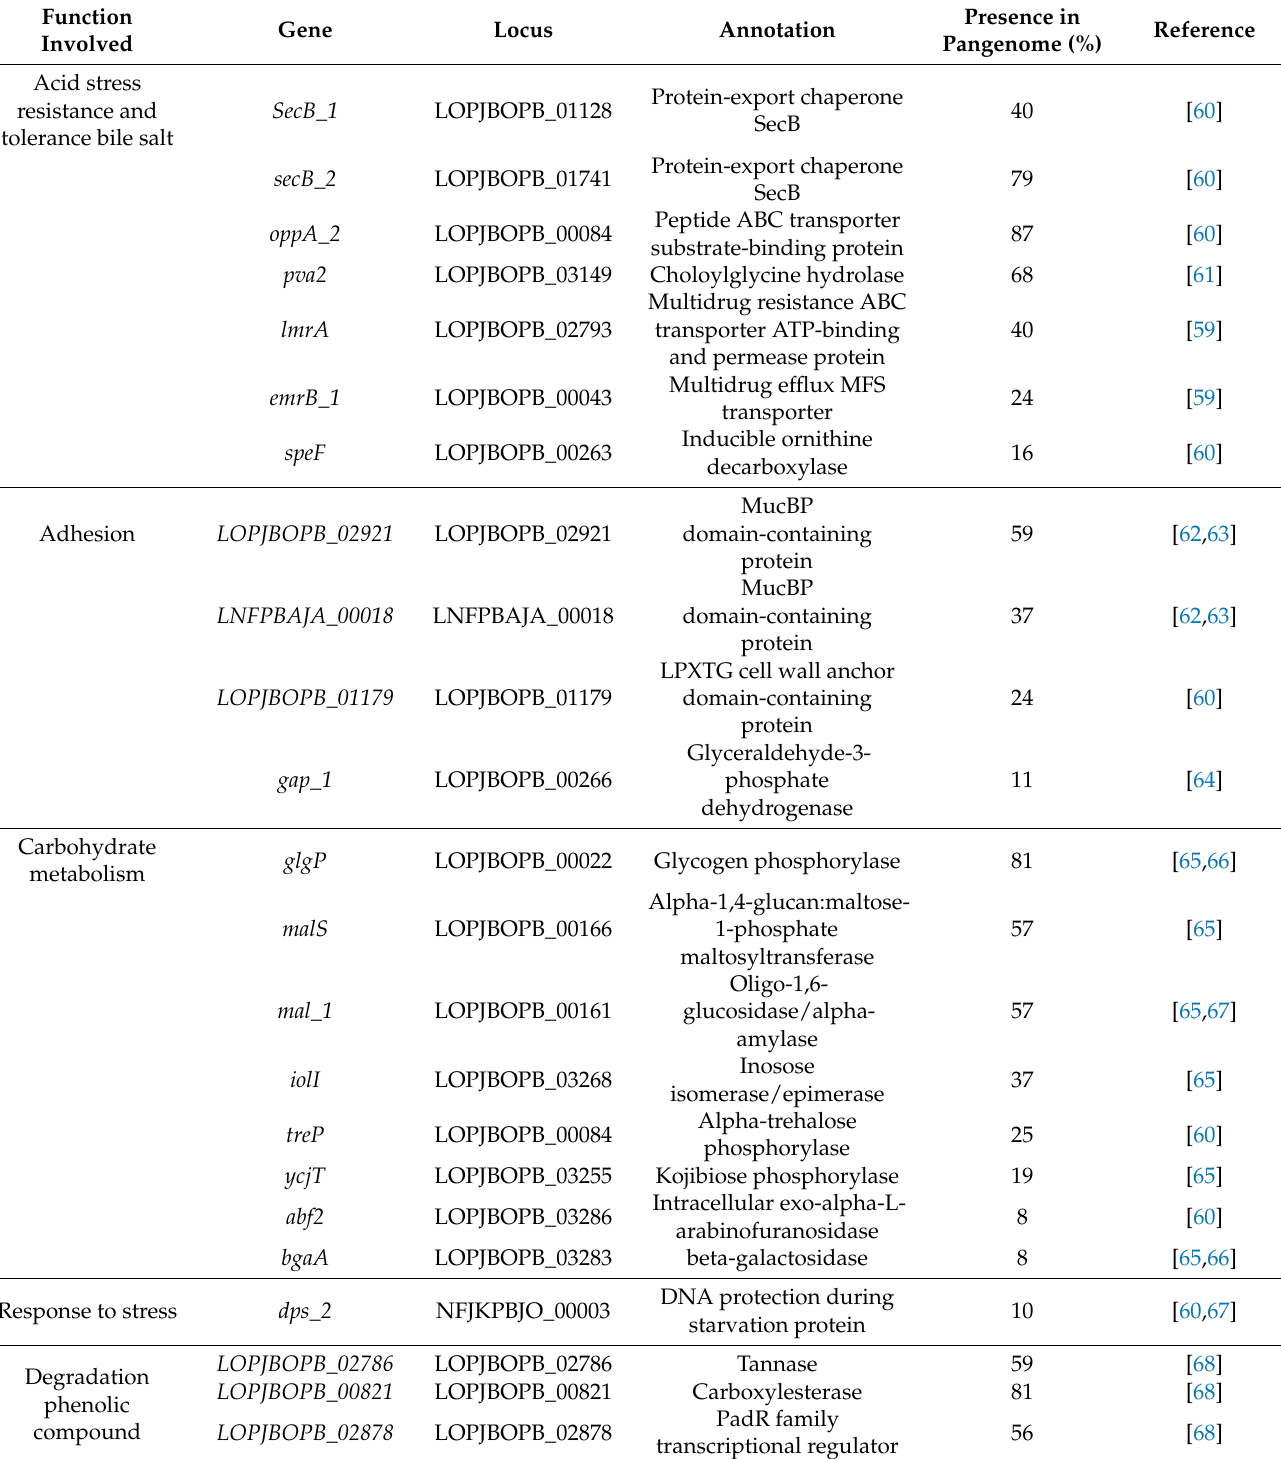
Table 1. Shell and cloud genes found in the LPG1 genome related to its probiotic and technological